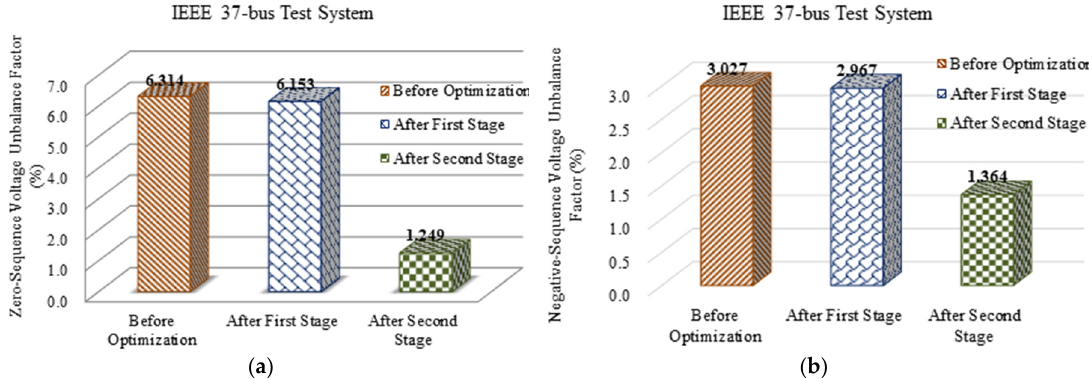
Figure 7. Simulation result of the voltage unbalance factors of the IEEE 37-bus test system: ( a ) zero- sequence voltage unbalance factor; and ( b ) negative-sequence voltage unbalance factor.